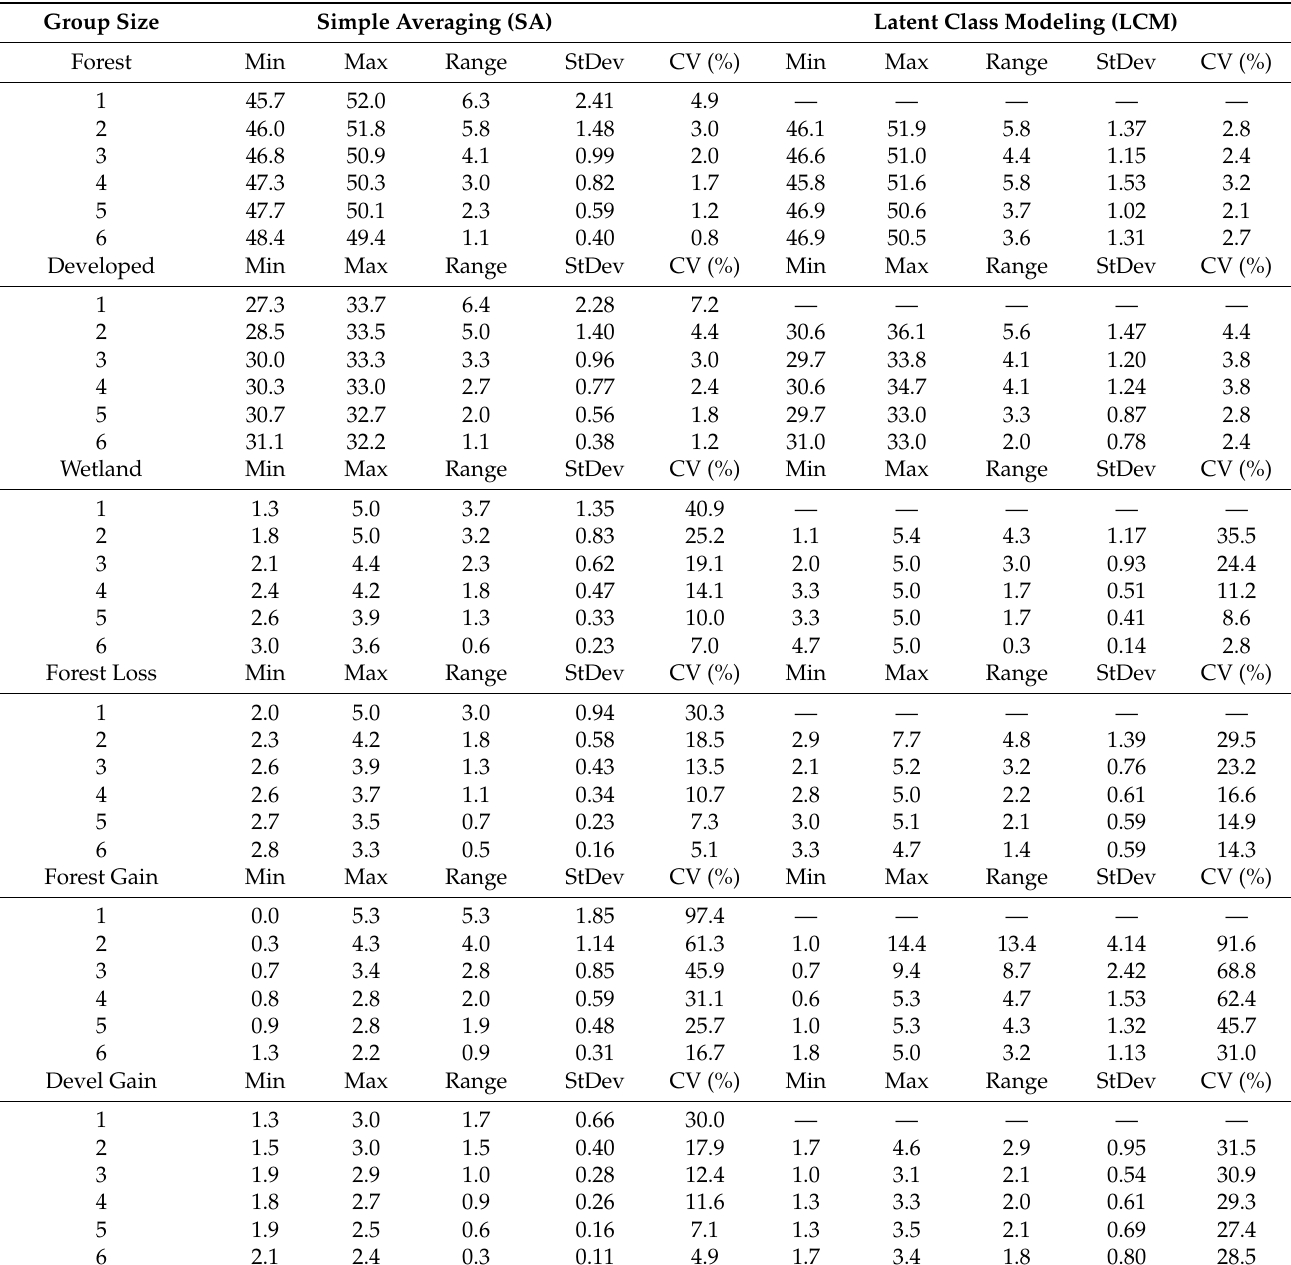
Table 6. Comparison of the variability of SA and LCM percent area estimates by interpreter group size (Min = minimum, Max = maximum, StDev = standard deviation, and CV % = coefficient of